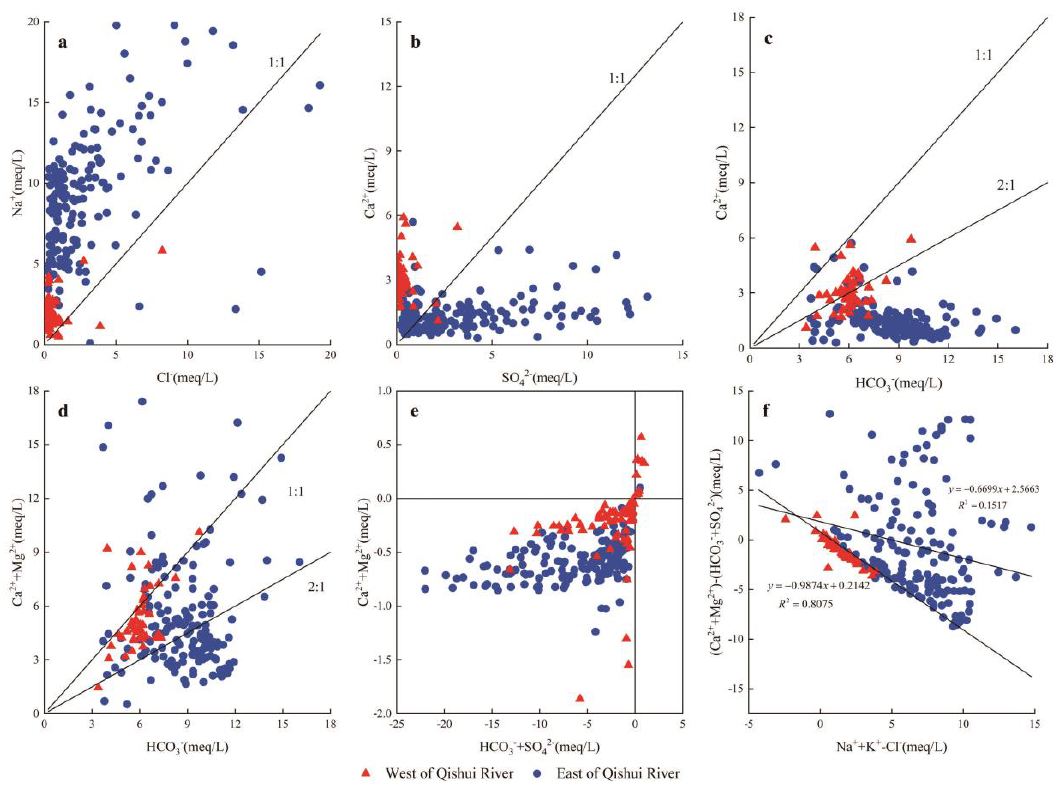
Figure 4. Bivariate diagrams of major ionic concentrations in groundwater samples ( a ): Na + vs. Cl − ; ( b ): Ca 2+ vs. SO 42− ; ( c ): Ca 2+ vs. HCO 3− ; ( d ): Ca 2+ + Mg 2+ vs. HCO 3− ; ( e ): Ca 2+ + Mg 2+ vs. HCO 3− + SO 42− ; ( f ): (Ca 2+ + Mg 2+ ) − (HCO 3− + SO 42− ) vs. Na + + K + − Cl − .